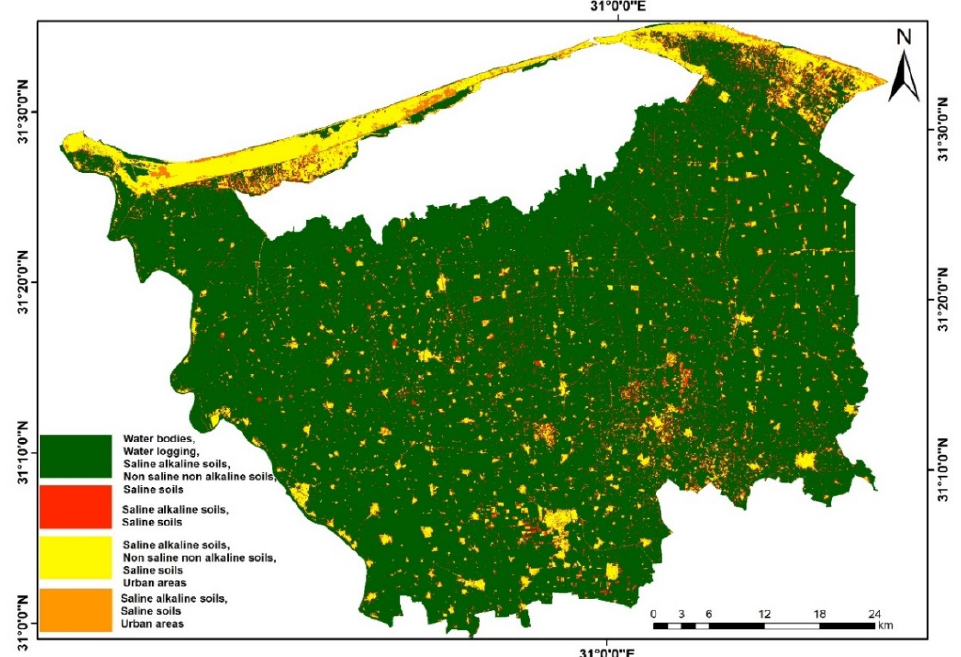
Figure 9. A 2002 map showing the SAfSoil results from the indices of Farifteh [72].